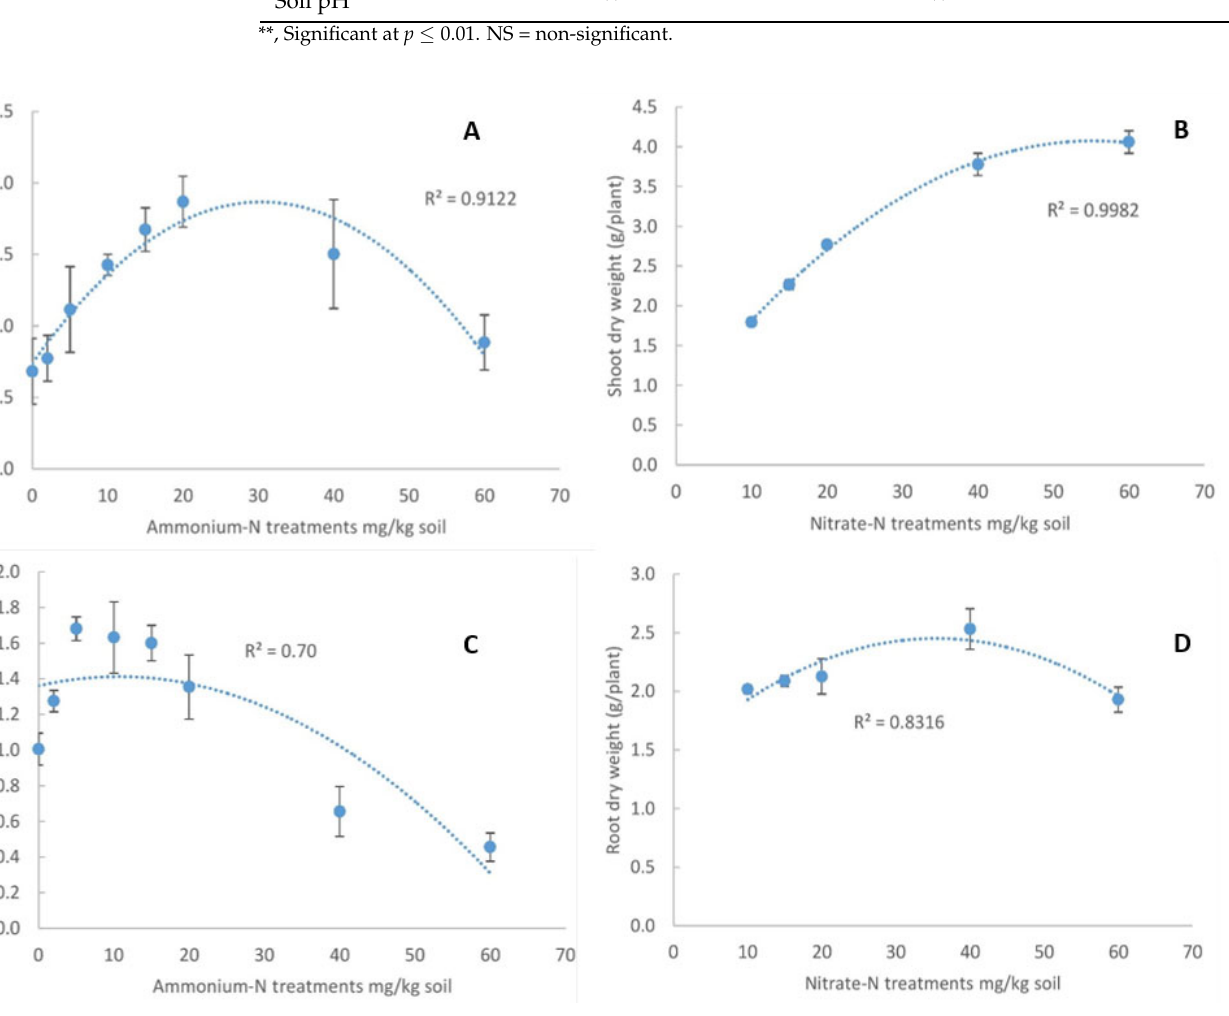
Figure 1. Effects of the ammonium (NH 4+ -N) and nitrate (NO 3 − -N) treatments on shoot ( A , B ) and root growth ( C , D ) of canola plants grown for 35 days (vegetative stage 1,5). Means ± SE (n = 4).